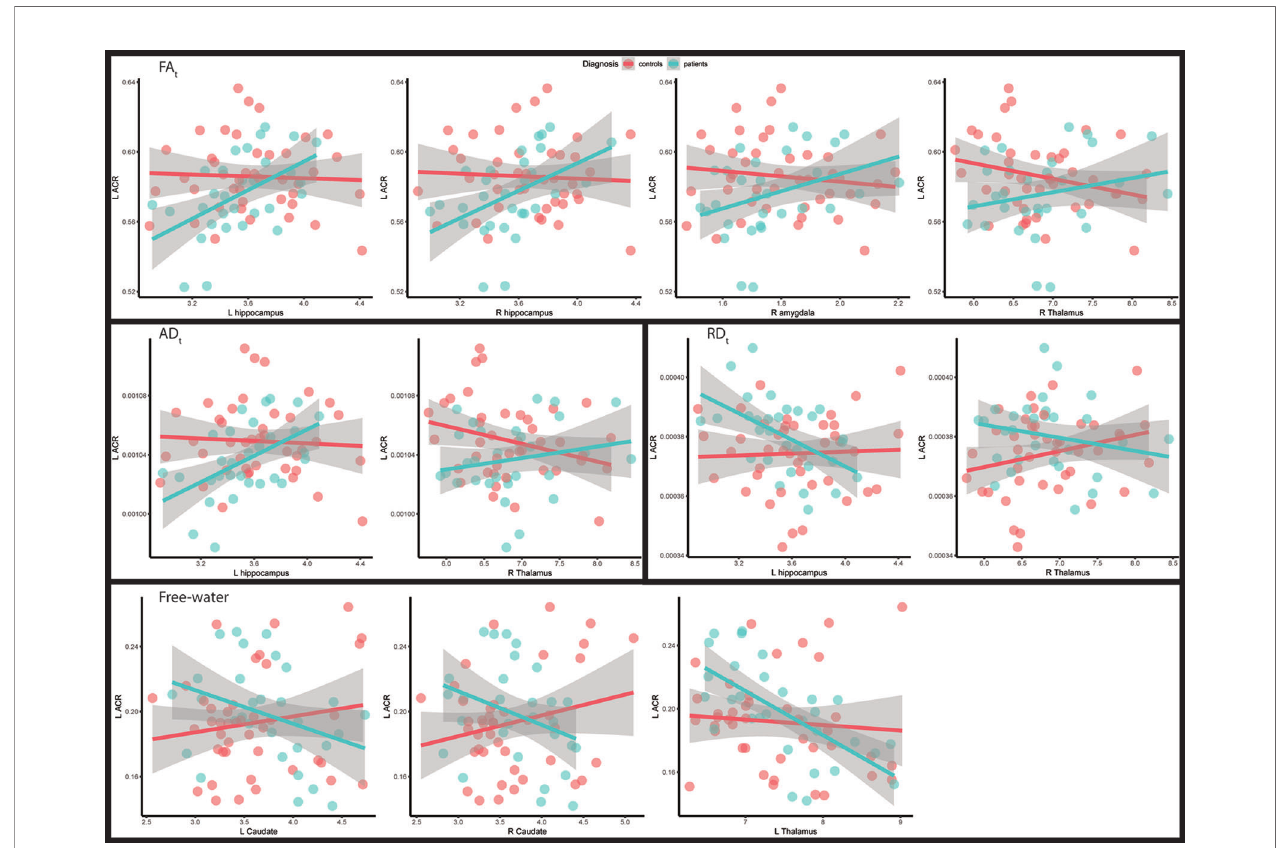
FIGURE 2 | Scatterplots of the left anterior corona radiata with the subcortical structures that have signi fi cant interaction with diagnosis. Fitted lines were created using a generalized additive model. AD t , Free-water adjusted axial diffusivity; ACR, anterior corona radiata; FA t , Free-water adjusted fractional anisotropy; L, Left; RD t , Free-water adjusted radial diffusivity; R, Right.